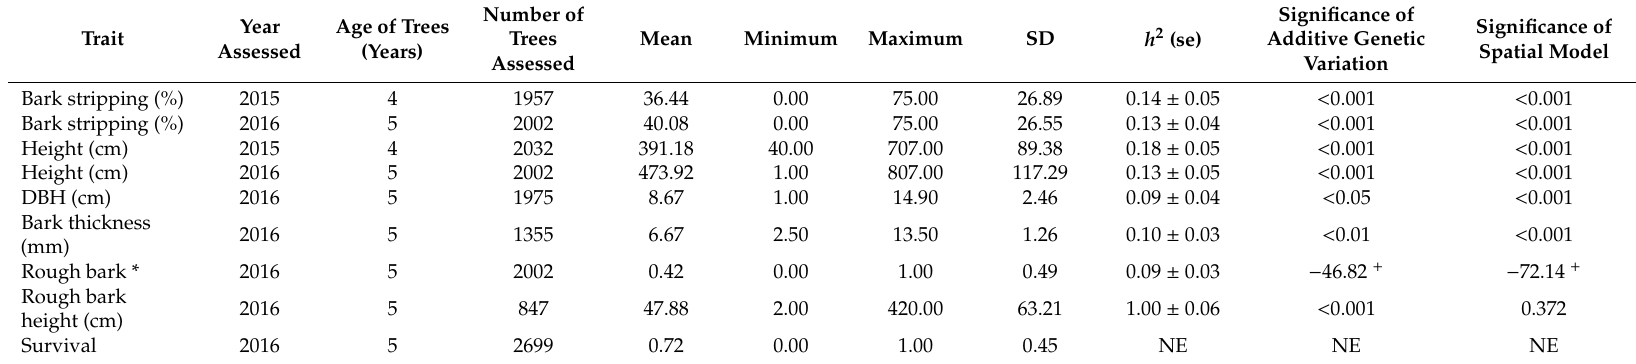
Table 2. Statistics for each trait assessed at Beulah. SD = standard deviation; h 2 (se) = narrow-sense heritability and its associated standard error estimated with univariate spatial models. The significance of the additive genetic variation and the spatial e ff ect on the model are also presented. For the binary trait rough bark (marked *), + signifies that the parameter was important based on the Akaike Information Criteria. Genetic variation was not estimated (NE) for survival, since it was high for most families.